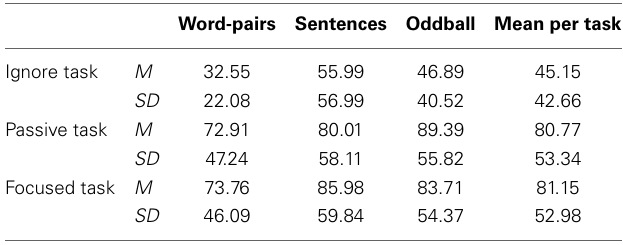
Table 1 | Mean values ( M ) and standard deviations ( SD ) of subjective effort listed for all three paradigms (columns) and tasks (rows).